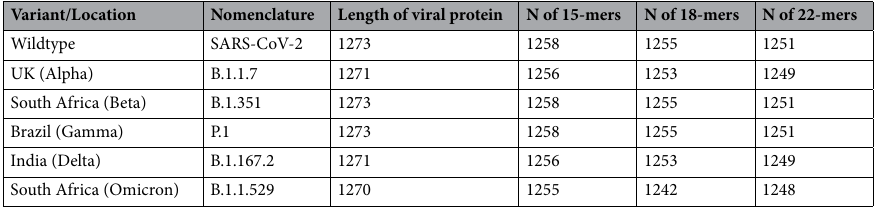
Table 1. SARS-CoV-2 spike glycoprotein